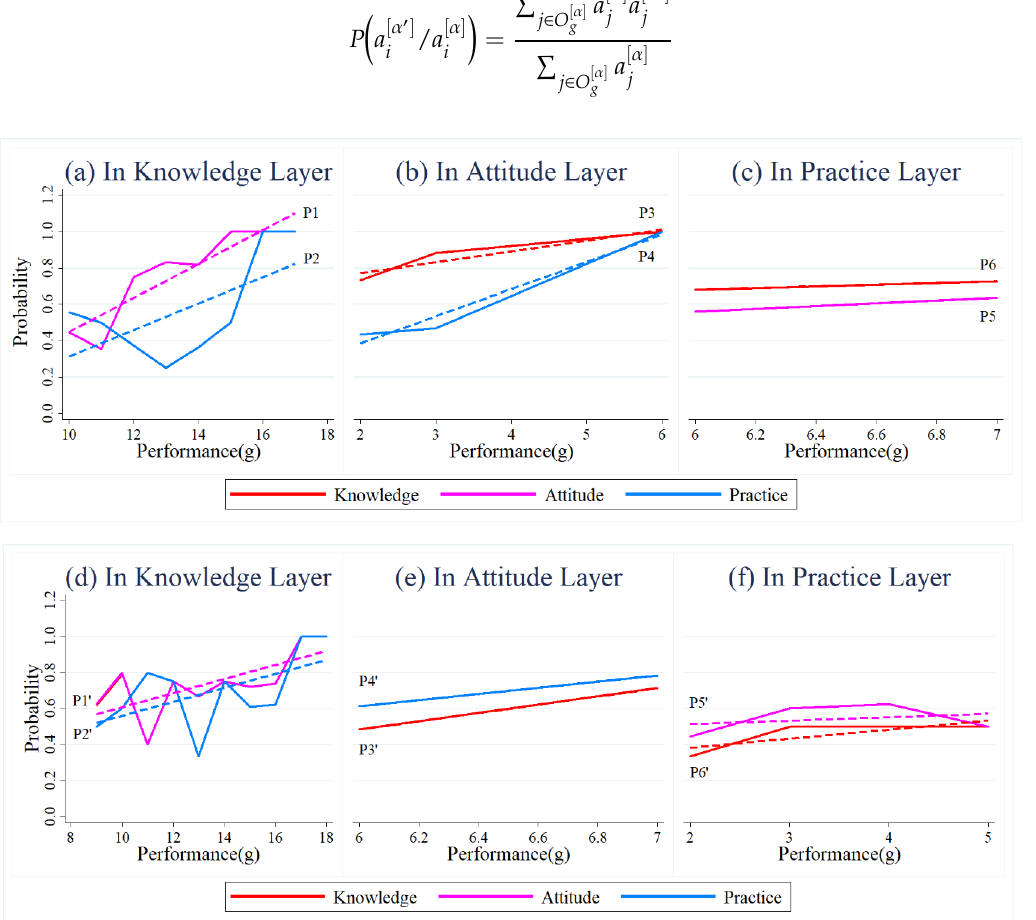
Figure 4. The relationships of individuals’ performance s at different layers. The solid and dashed lines, respectively, represent true and linear fitted values. The x -axes refer to the performance of the FSWs in 𝑂 𝑔[𝛼] , who have the same positive ( a – c ) or negative ( d – f ) responses on the questionnaire in the 𝛼 layer. The y -axes refer to the proportion of these FSWs in subset 𝑂 𝑔[𝛼] also being positive ( a – c ) or negative ( d – f ) in the other two layers. Please refer to Appendix Table A2 for the fitted equations and parameters of the models as well as the results of significant testing. We only provided the conclusions when the fitted lines passed the related significant testing.